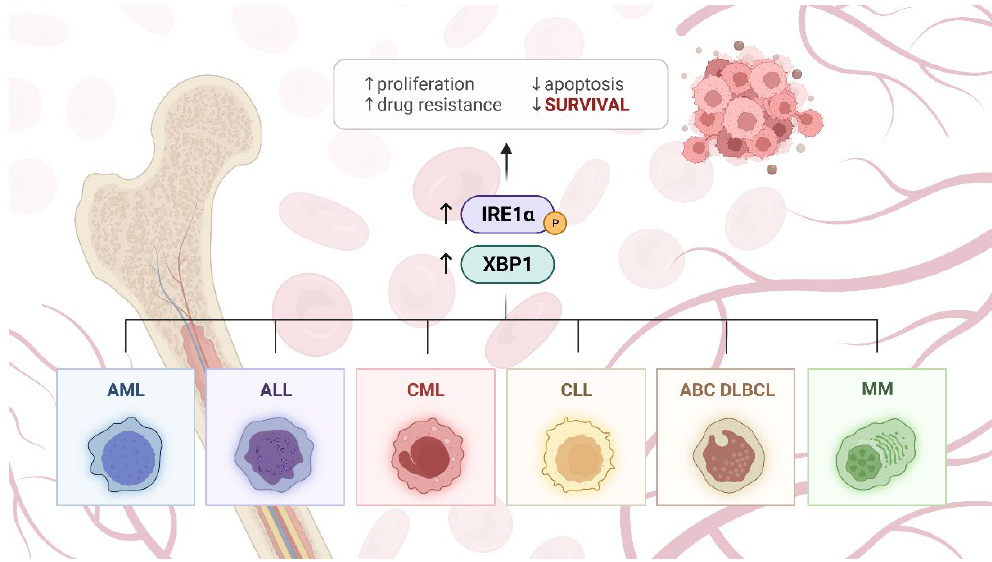
Figure 2. IRE1α -dependent signaling in blood cancer cells: The increased expression of IRE1α and its major substrate XBP1 may be observed in various hematological malignancies, including AML, ALL, CML, CLL, ABC DLBCL, or MM. In most cases, activation of IRE1α –XBP1 pathway results in enhanced proliferation and chemoresistance of cancer cells, while the rate of apoptosis is decreased, and patient survival is significantly poorer, compared with the mentioned tumor-non-expressing UPR-related proteins. Table 1. Distinct roles of IRE1 α -dependent XPB1 signaling in various hematological diseases. Disease Name The Role of